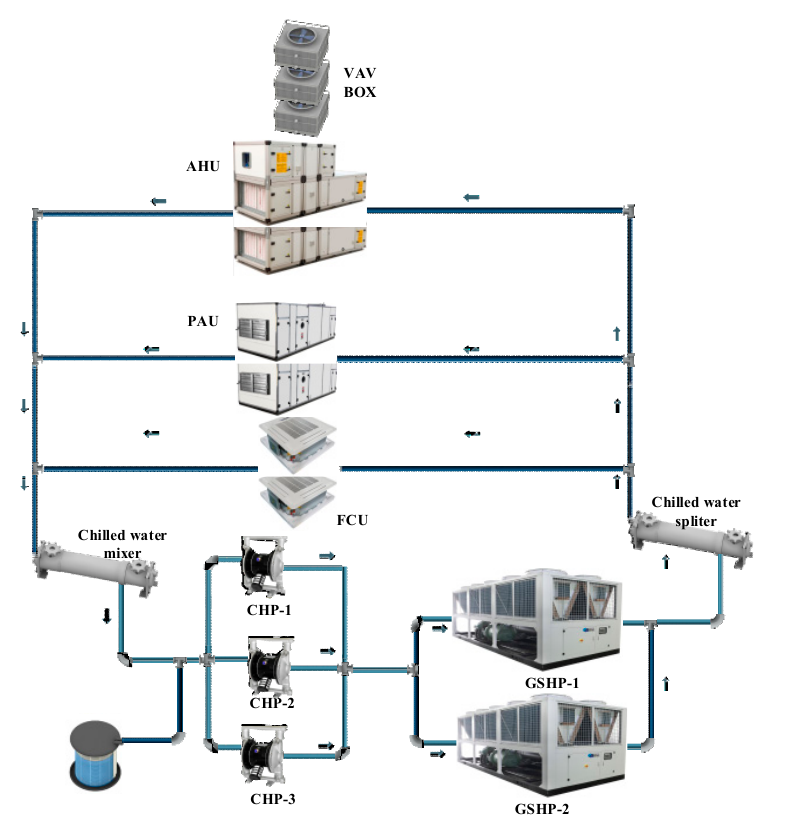
Figure 6. HVAC system schematic diagram.